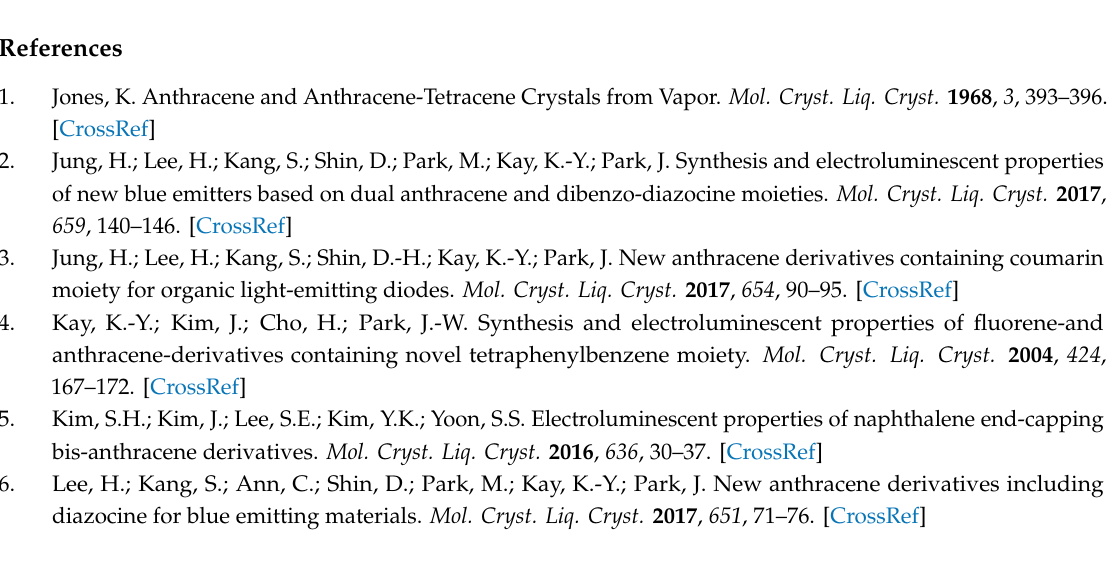
Table S1: The calculated bond distances and angles compared to the experimental data of aza-Michael product 3 a